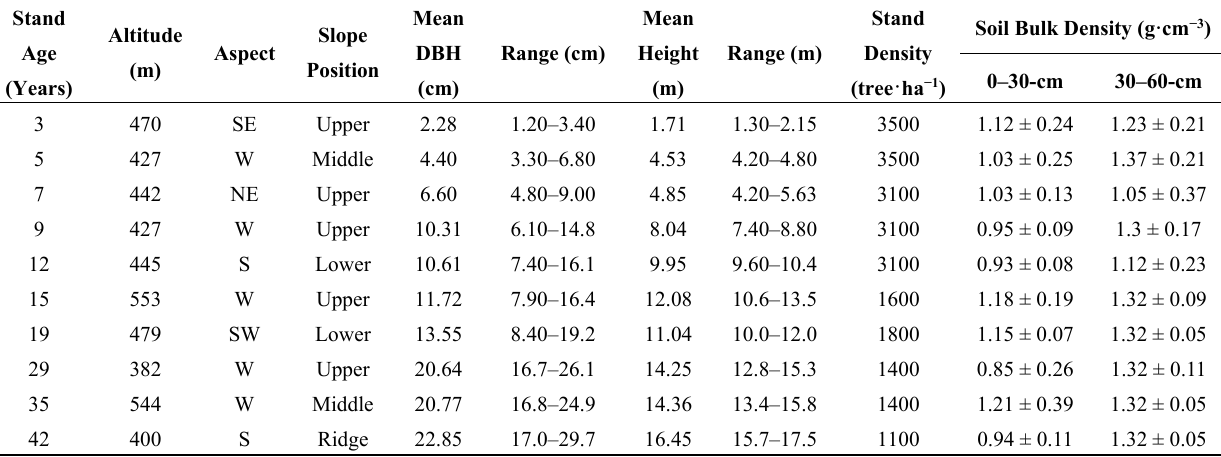
Table 1. Characteristics of the Pinus massoniana plantation forest in Gao County, Sichuan